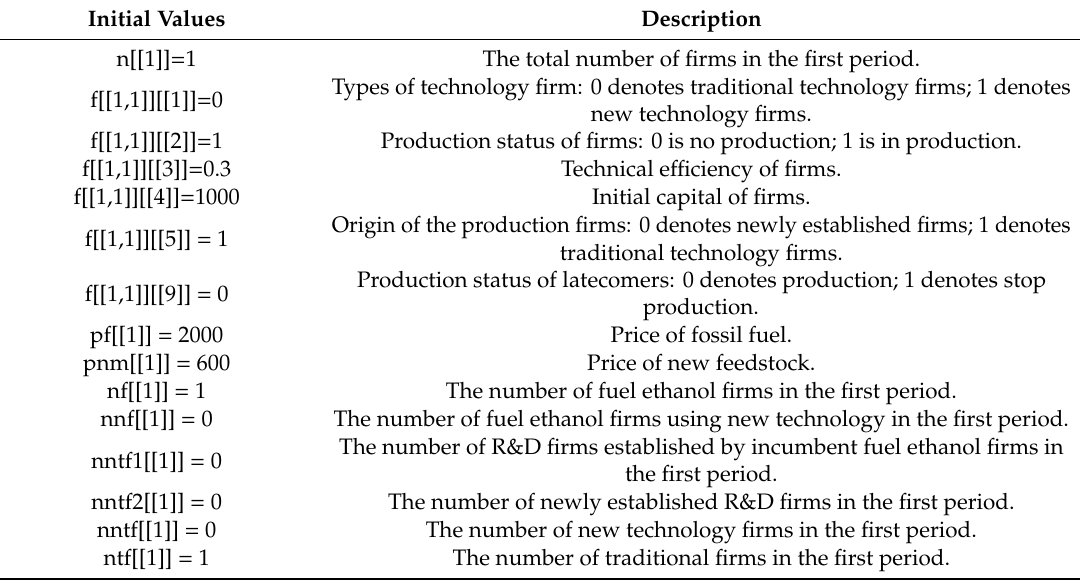
Table A1. The initial values of the variables in the coevolutionary model of the fuel ethanol industry (baseline